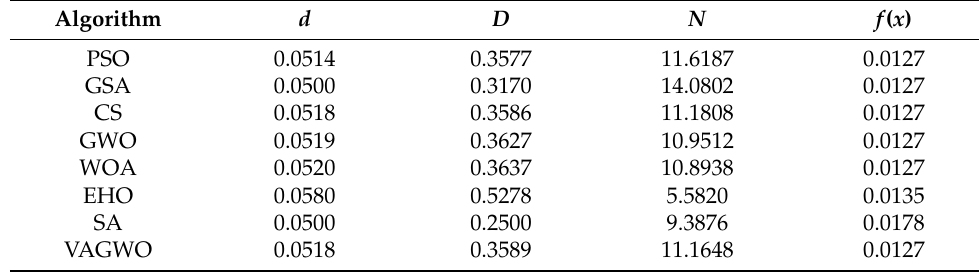
Table 17. Minimization results of tension/compression spring